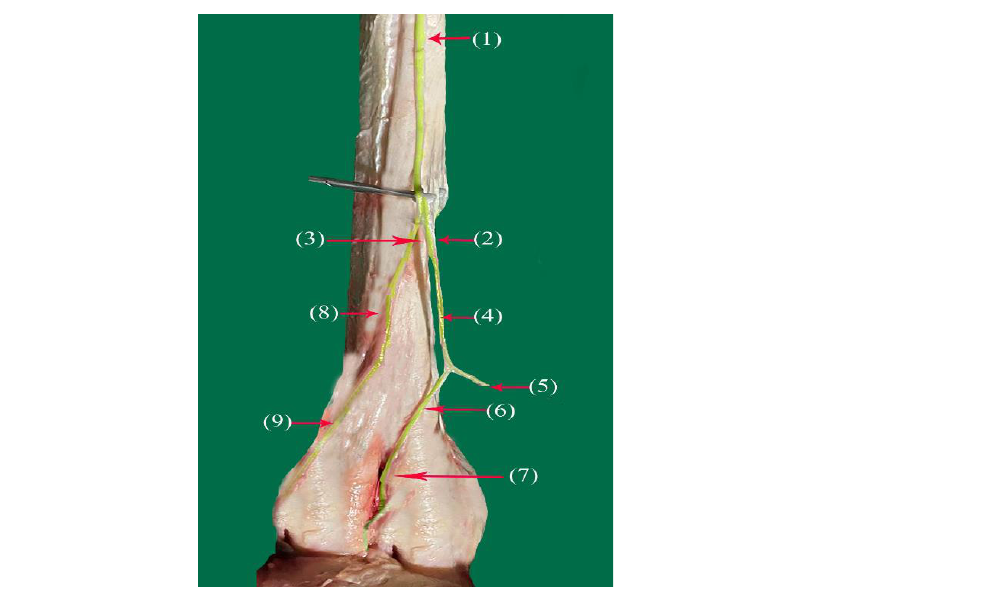
Figure 3. Nerve supply of the dorsal surface of the distal hindlimb in camels: (1) superficial fibular nerve; (2) common dorsal nerve of the IV digit; (3) common dorsal nerve of the III digit; (4) axial dorsal proper nerve of the III digit; (5) abaxial dorsal proper nerve of the III digit; (6) abaxial dorsal proper nerve of the IV digit; (7) axial dorsal proper nerve of the III digit; (8) axial dorsal proper nerve of the IV digit.